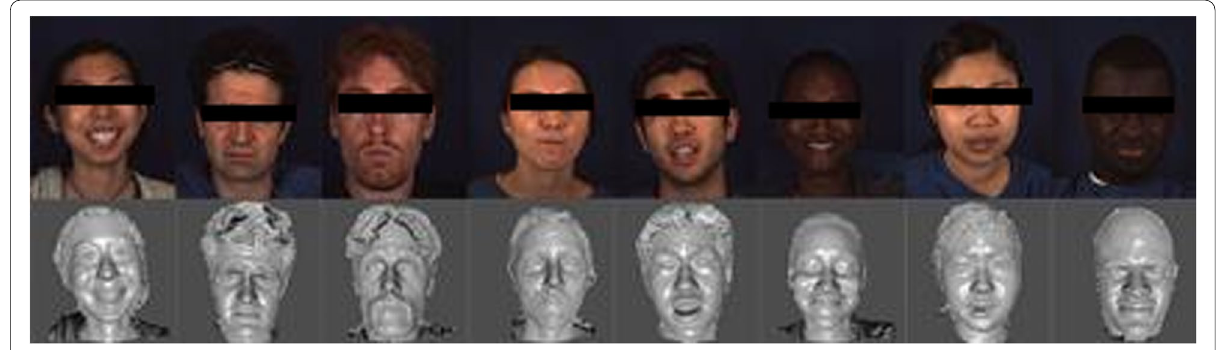
Fig. 10 Sample BP4D-Spontaneous datasets